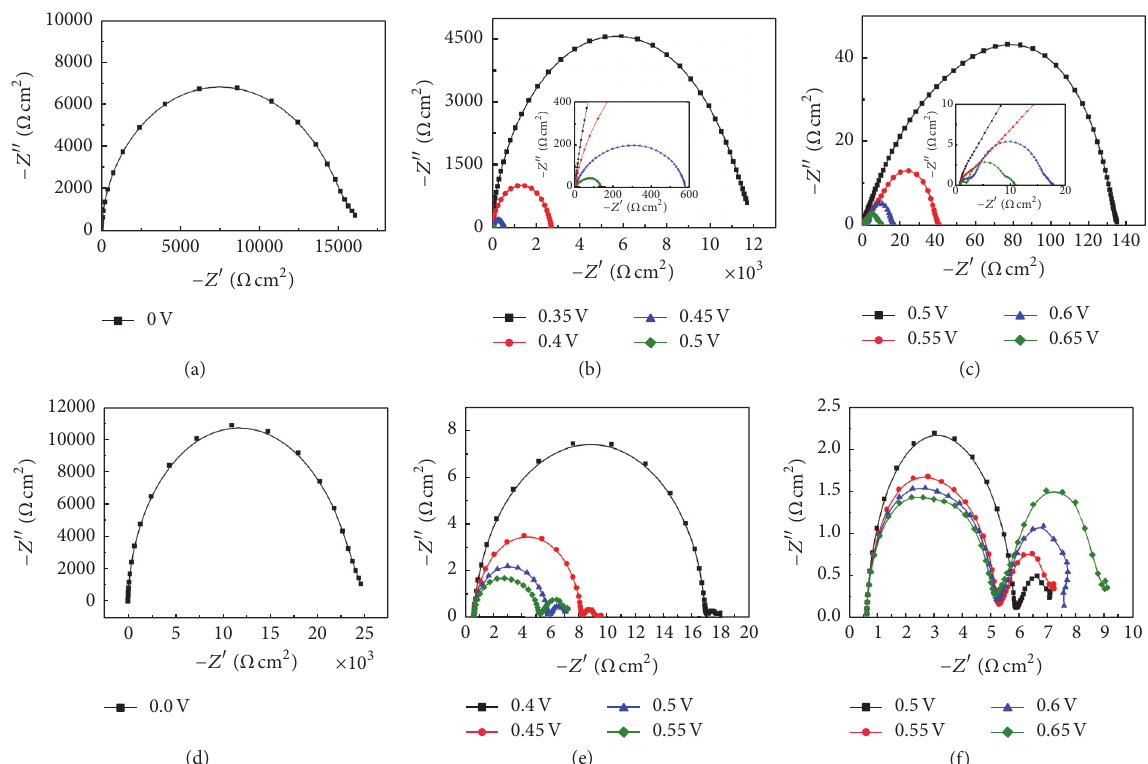
Figure 4: Nyquist plot for fresh DSC (a) at 0 bias, (b) near knee voltage, and (c) near 𝑉 OC , respectively. Nyquist plot for degraded DSC (d) at 0 bias, (e) near knee voltage, and (f) near 𝑉 OC , respectively.